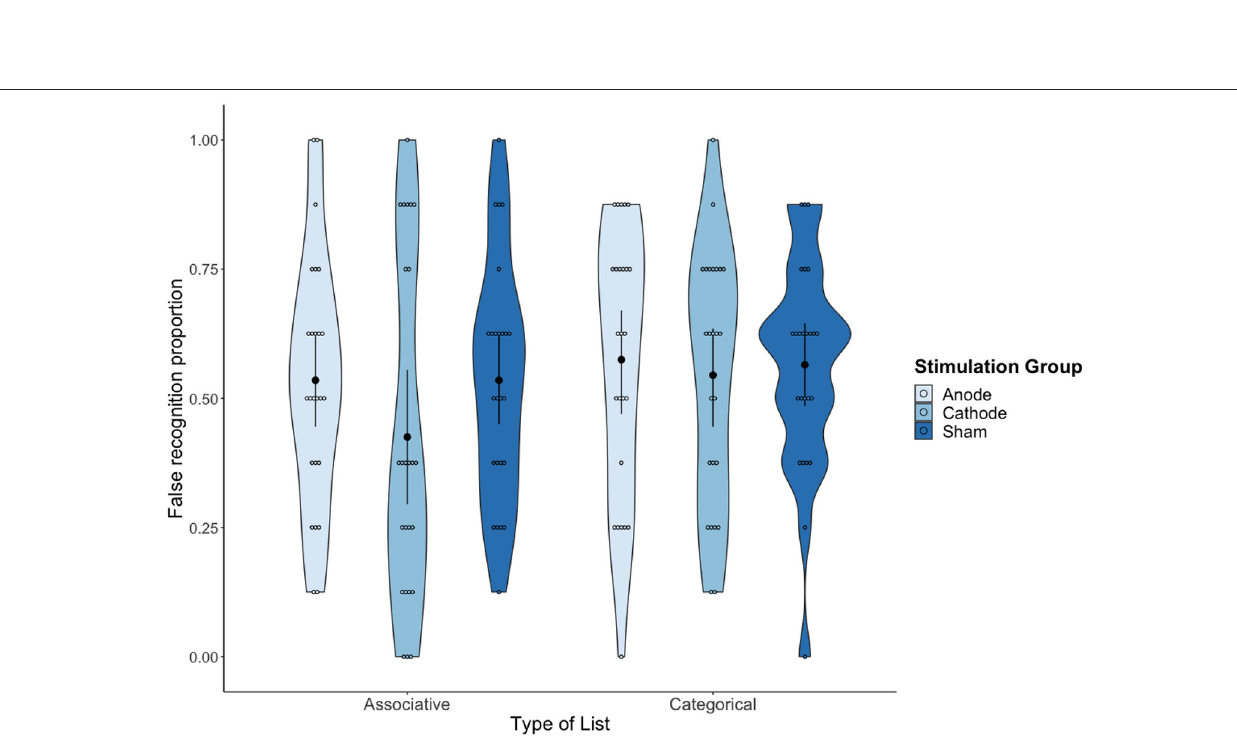
Frontiers in Psychology |